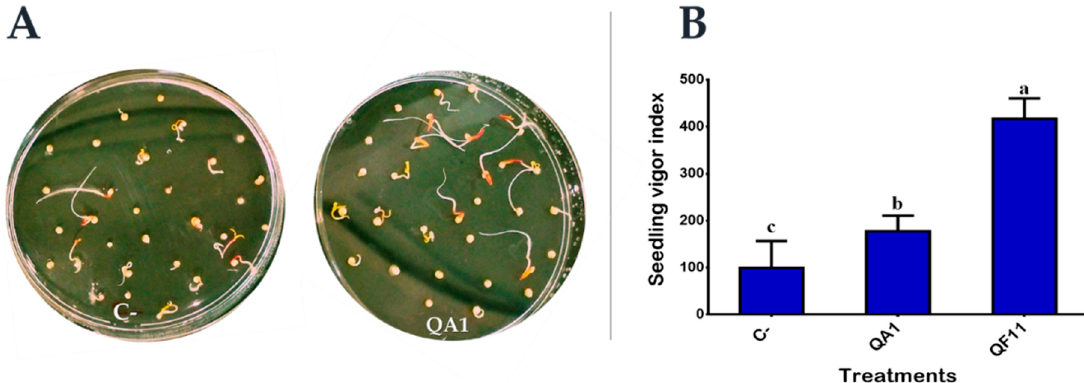
Figure 5. Effect of bacterial inoculation on early quinoa seeds germination and seedlings. ( A ) Germination rates monitored after 48 h of incubation in the dark at 25 °C. ( B ) Seedling vigor index of germinated quinoa seeds. C-, seeds treated with sterile distilled water; QA1, seeds treated with PSB QA1; QF11, seeds treated with PSB QF11. The values represent means of replicates ( n = 3) ± standard deviations. The different letters in superscript (a, b, c…) indicate the statistically significant difference at 95% between treatments.